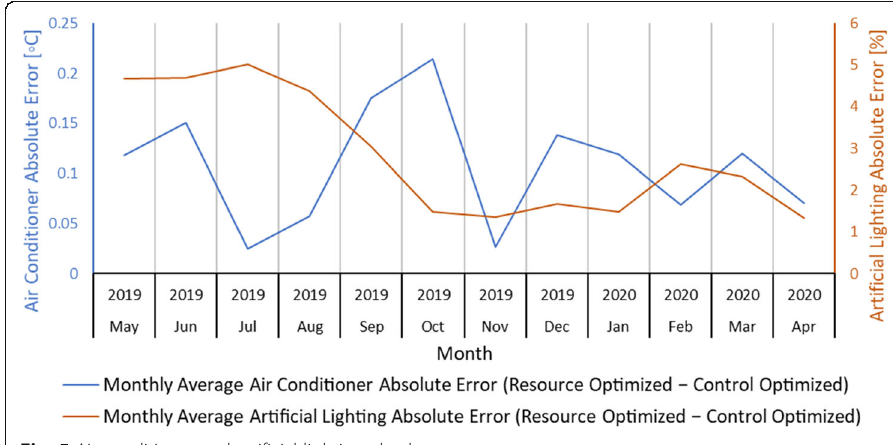
Fig. 5 Air conditioner and artificial lighting absolute